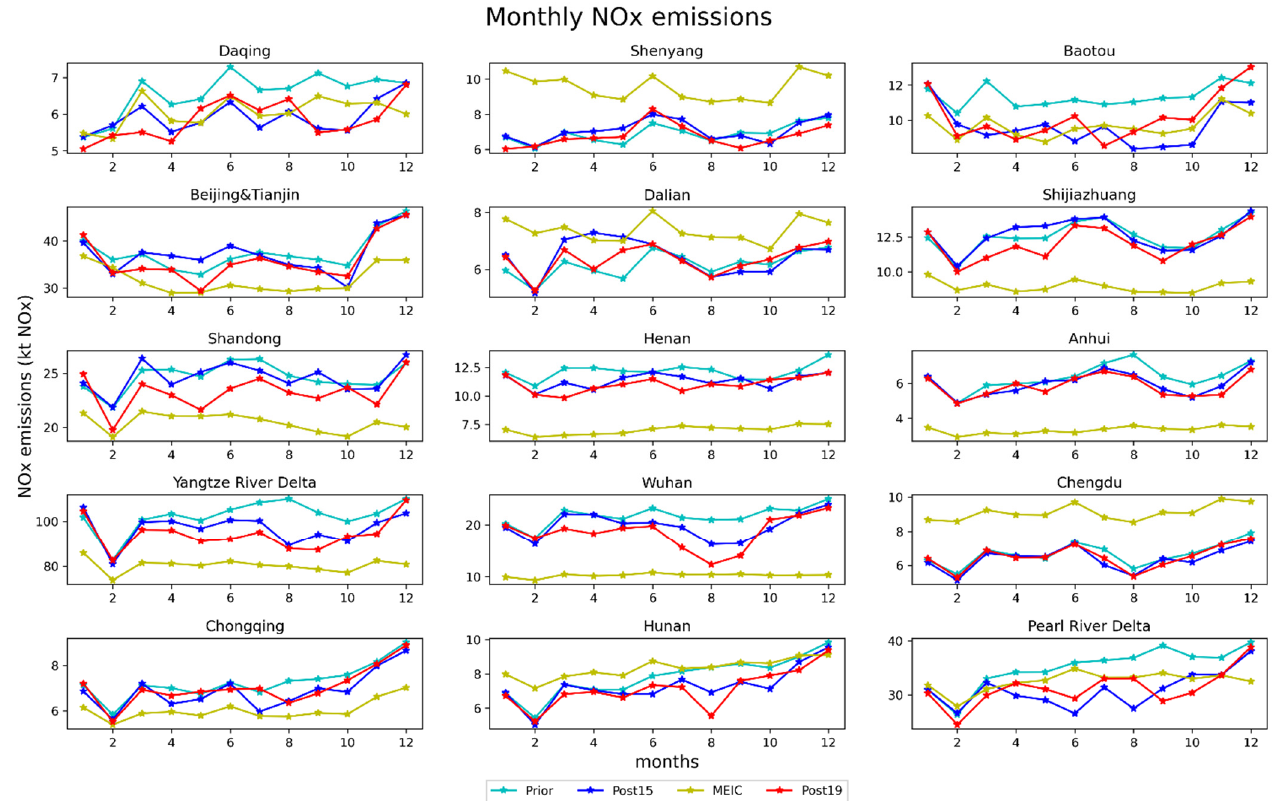
Figure 7. NO x monthly budget comparisons at the selected locations.